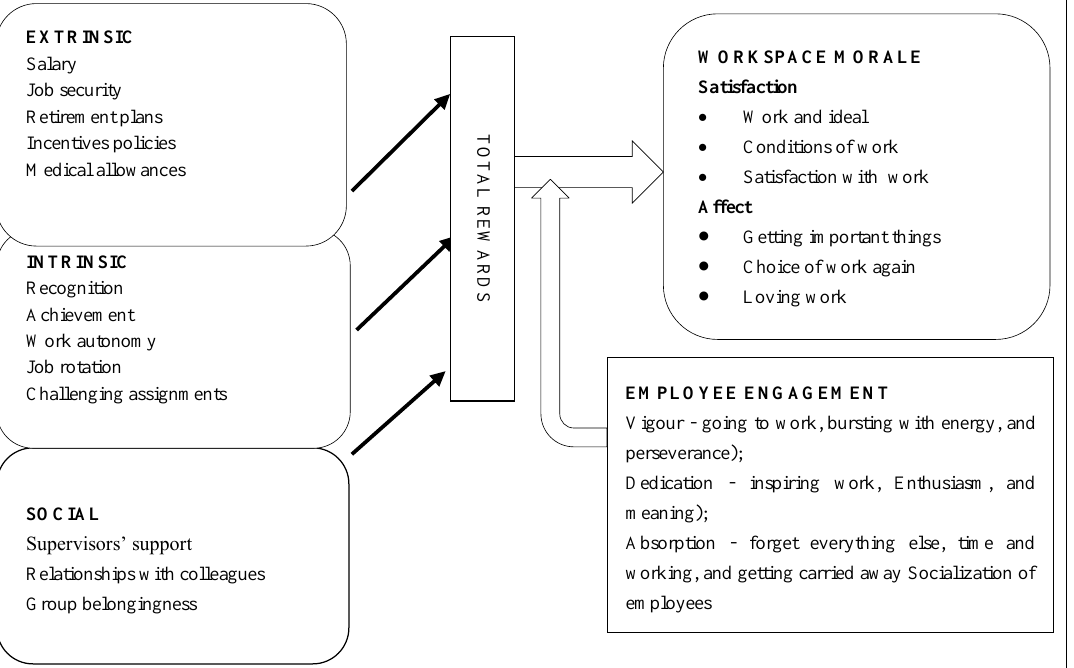
Figure 1: Conceptual Model of the Study; Source: Authors